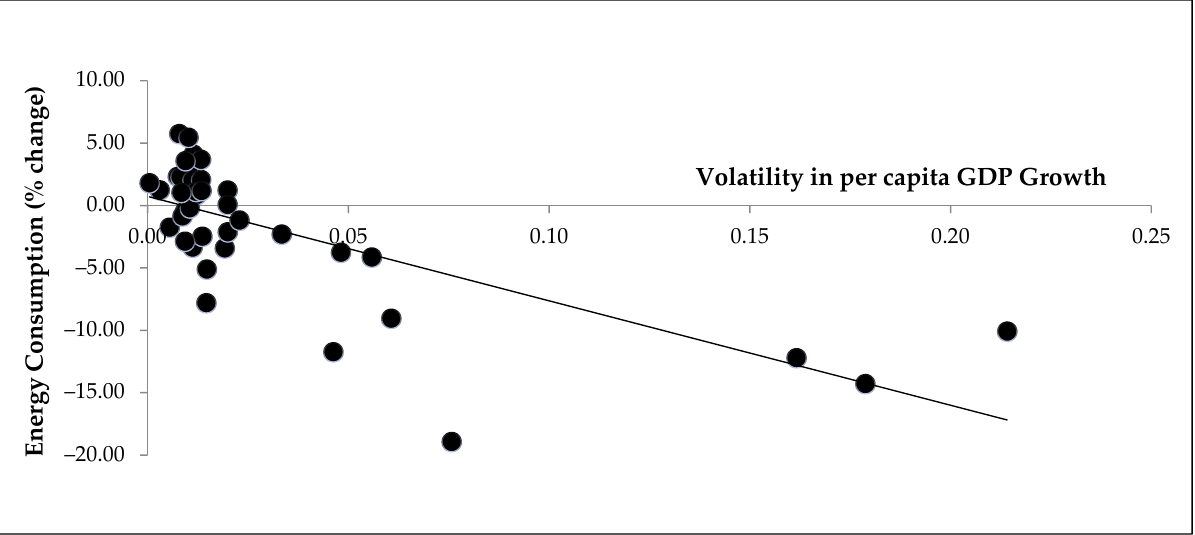
Figure 3. ( a ) Real GDP per capita and energy consumption per capita; ( b ) income and energy intensity (period averages for 1970–2016).